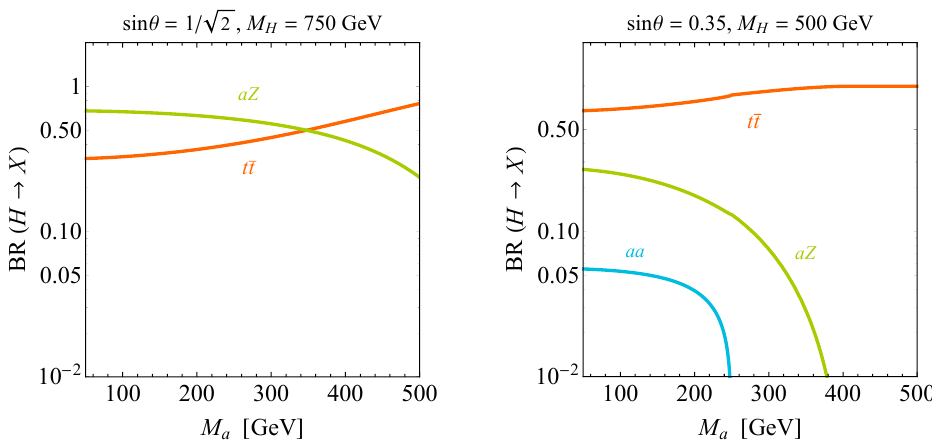
Figure 4 . Branching ratios of the heavier scalar H as a function of M a for two di(cid:11)erent choices of sin (cid:18) and M H as indicated in the headline of the plots. The other used input parameters are tan (cid:12) = 1, M A = M H (cid:6) = 750 GeV, (cid:21) 3 = (cid:21) P 2 = 0 and (cid:21) P 1 =